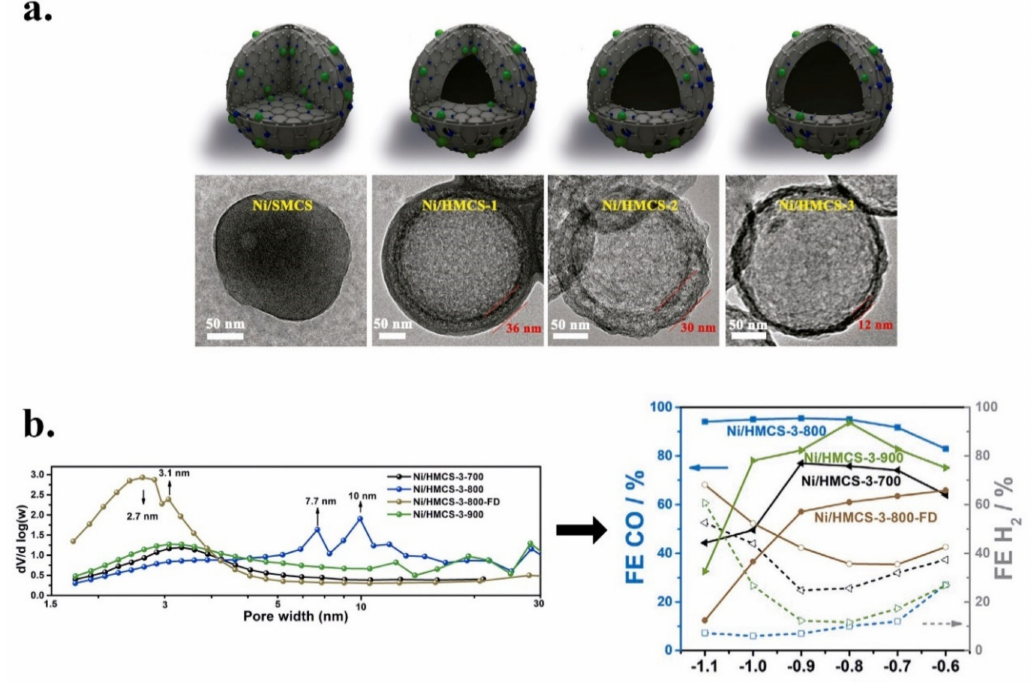
Figure 19. Relationship between geometric parameters ( a ) carbon shell ( b ) pore size on electrochemical performance. Adapted from